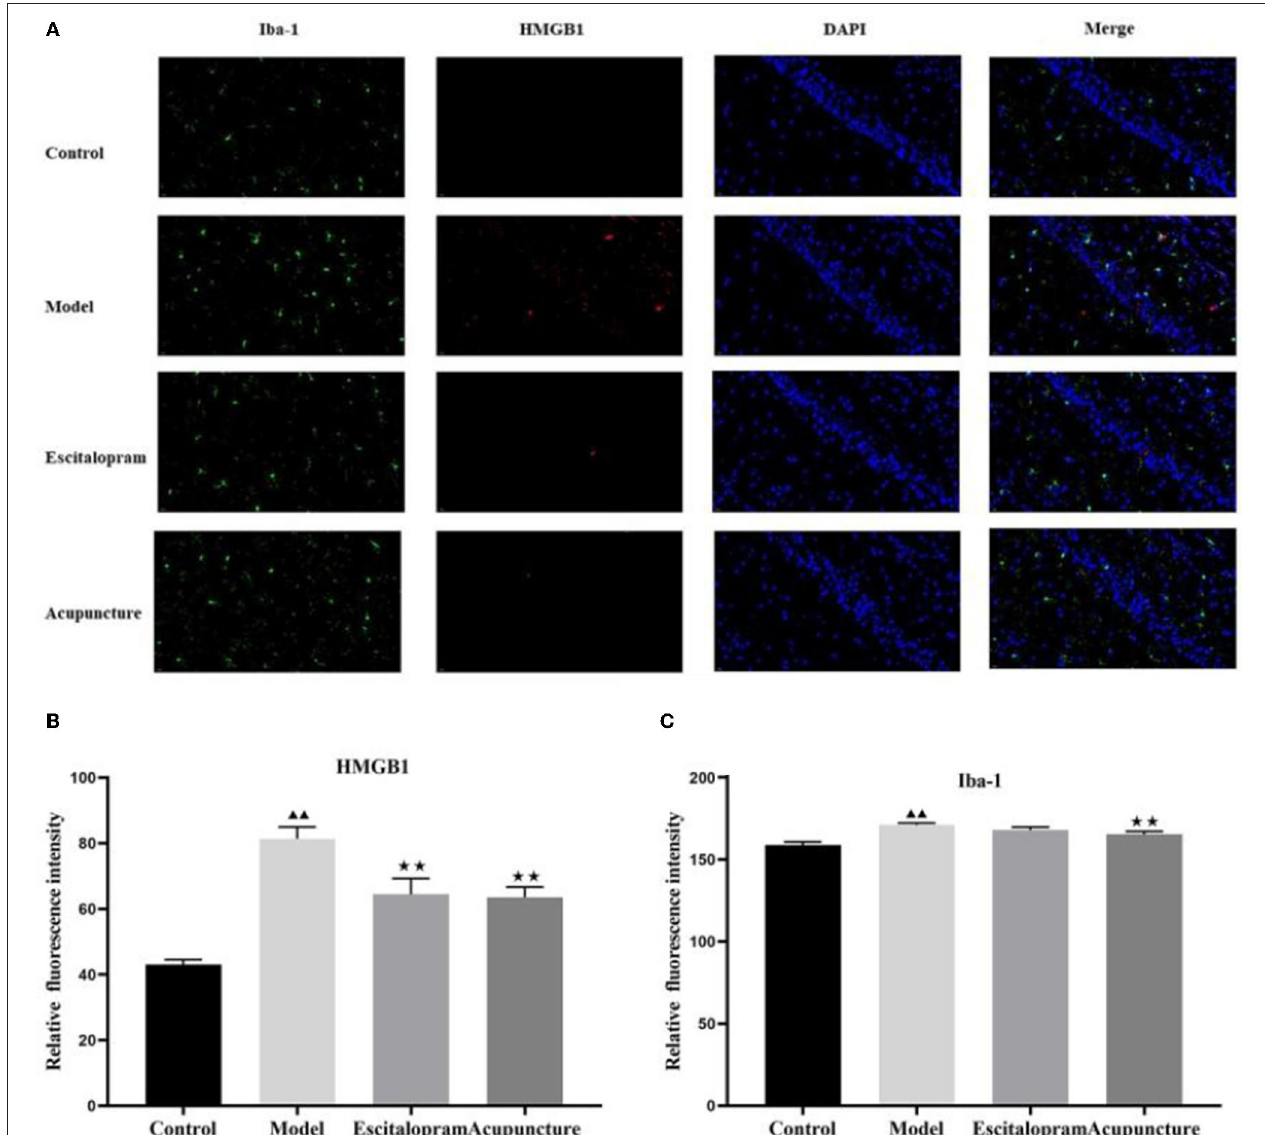
FIGURE 3 | Effect of acupuncture on the expression of HMGB1 and IBA-1 in the hippocampus of CRS rats. (A) Immunofluorescence staining of hippocampal CA1 region in different groups ( × 40). IBA-1, green; HMGB1, red; DAPI, blue; scale bar, 20 µ m; (B) Relative fluorescence intensity of HMGB1; (C) Relative fluorescence intensity of IBA-1. Data was expressed as means ± SEM (n = 5). NN P < 0.01, compared with control group; ⋆⋆ P < 0.05, compared with model group. One-way ANOVA followed by LSD’s post-hoc